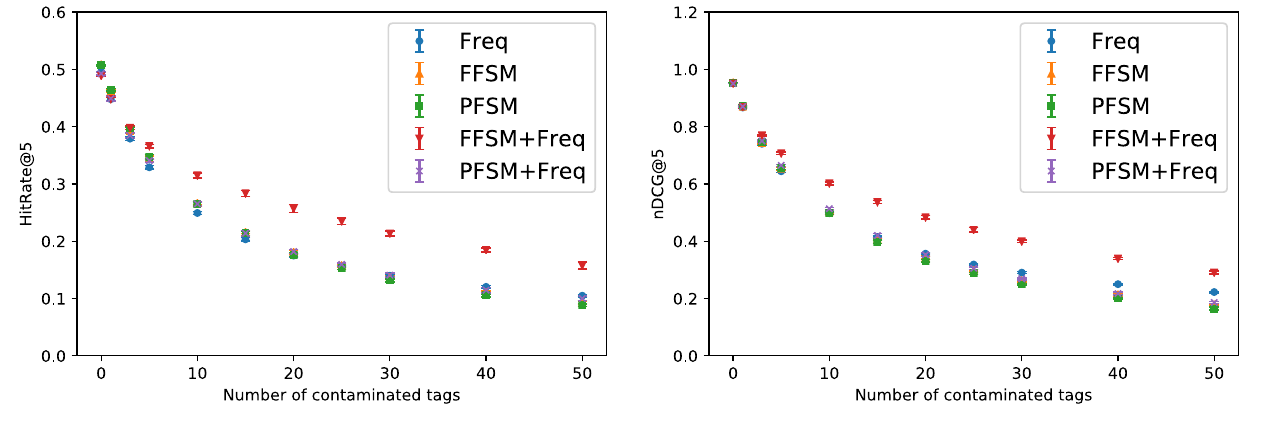
Fig. 5 Model performances regarding relevance